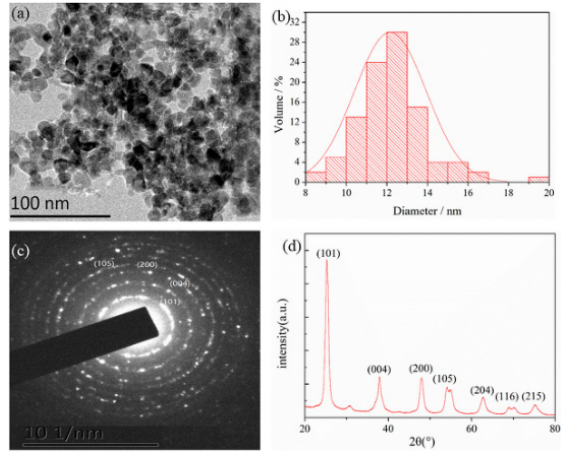
Figure 1. ( a ) TEM images, ( b ) size distribution, ( c ) selected area electron diffraction (SAED), ( d ) XRD of amino-capped TiO 2 NPs.